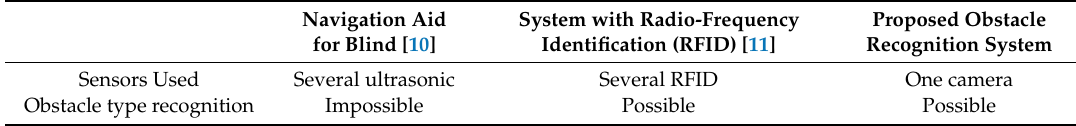
Table 1. Comparison between related works and the proposed